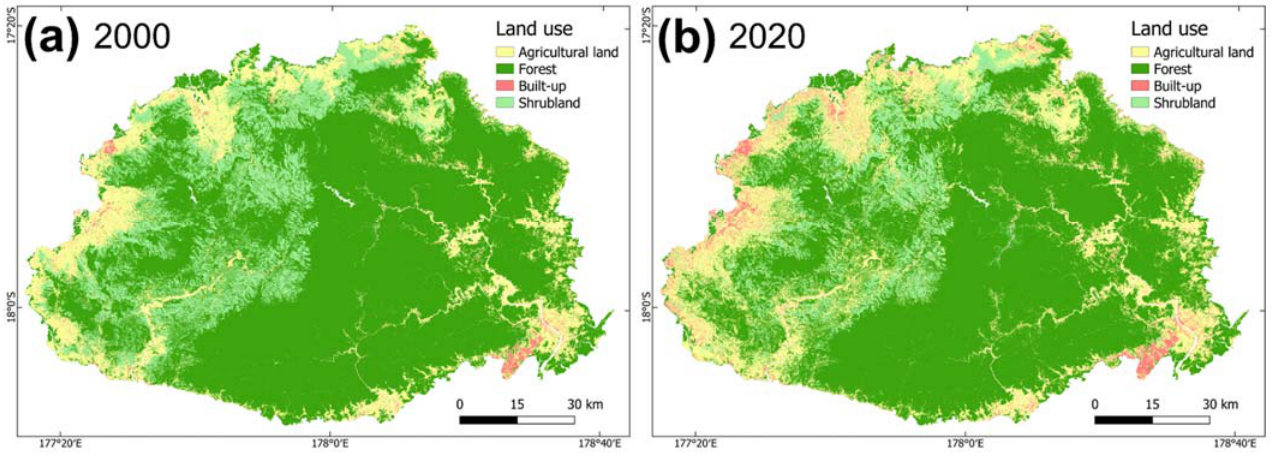
Figure 4. Land use land cover maps of 2000 and 2020.